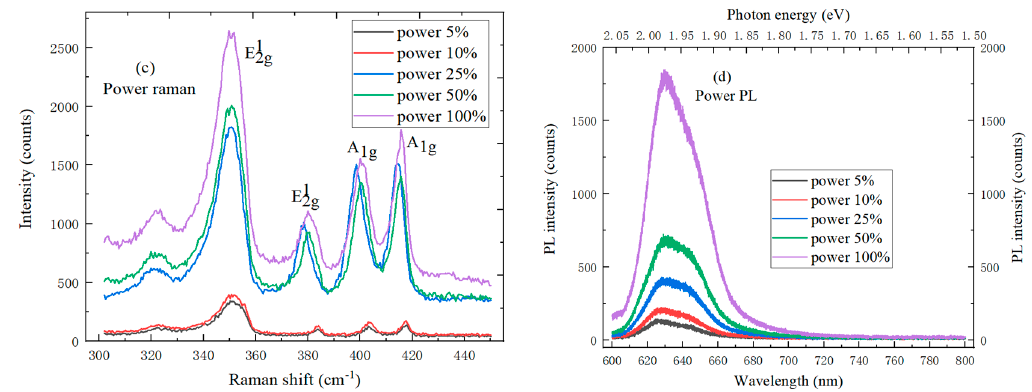
Figure 7. ( a ) Raman spectrum and ( b ) PL spectrum of MoS 2 / WS 2 hetero-junction on SiO 2 / Si substrate at five points; ( c ) Power Raman spectrum and ( d ) Power photoluminescence spectrum of MoS 2 / WS 2 hetero-junction on SiO 2 / Si substrate.